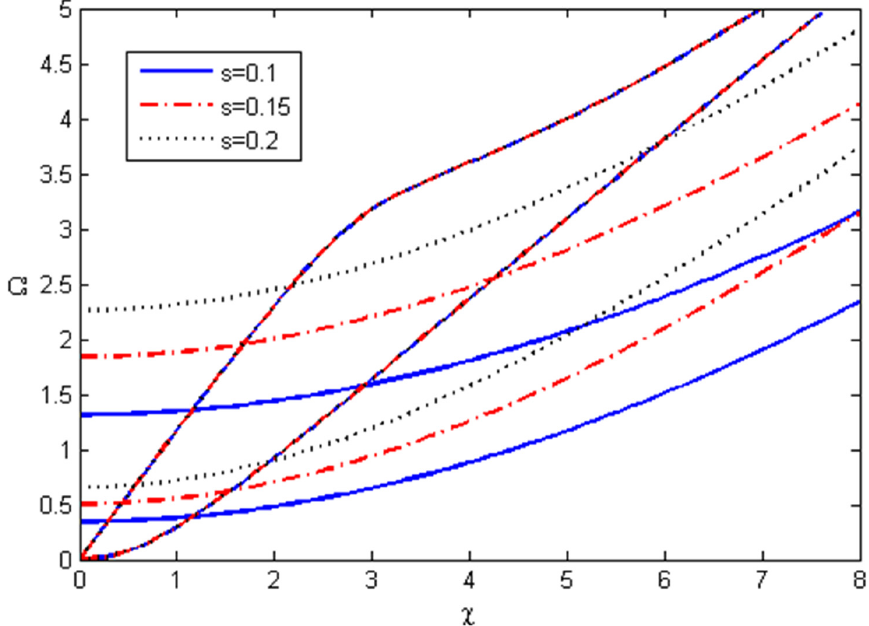
Figure 7. The dispersion spectra of GPLs-reinforced plates with different aspect ratios.